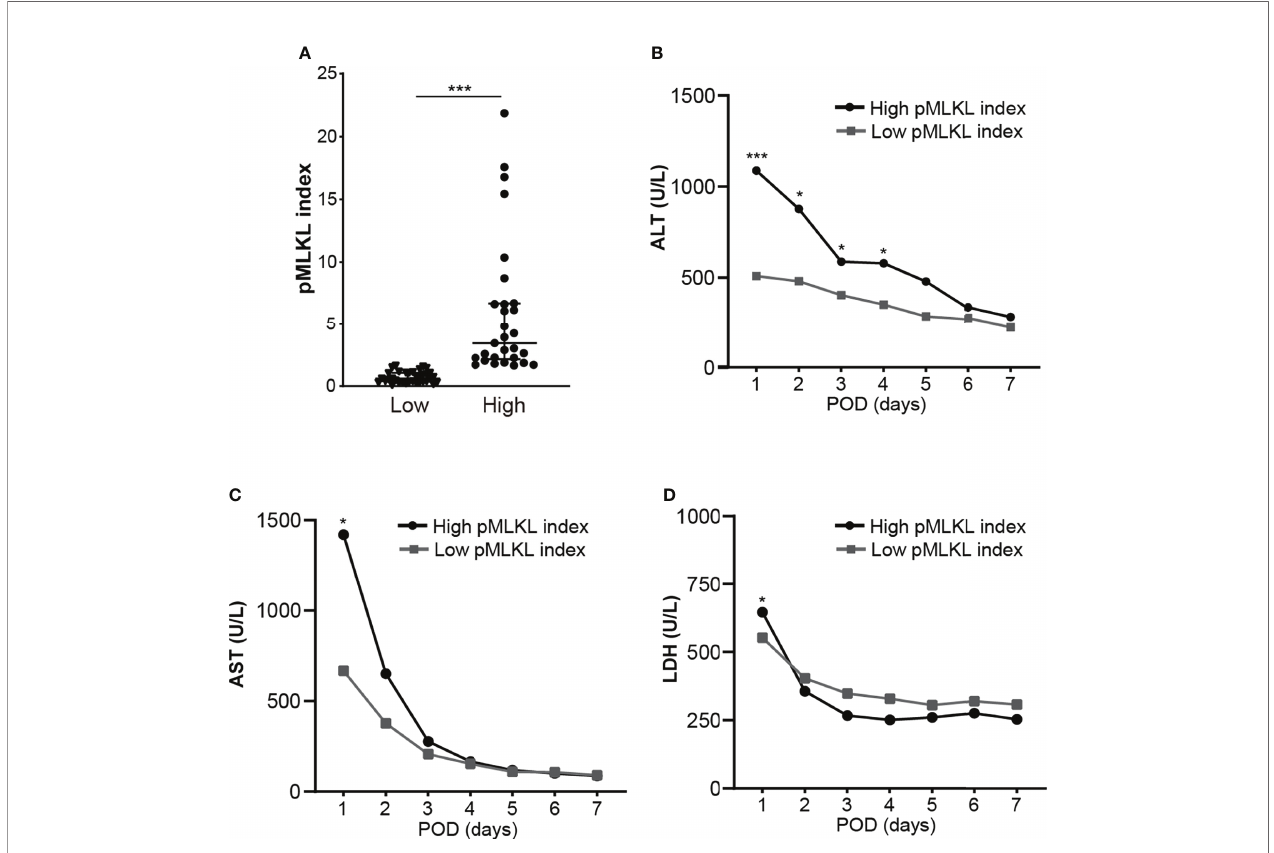
FIGURE 3 | The histological score of pMLKL correlates with early liver injury after reperfusion. (A) The dichotomy of graft pMLKL index is grouped as low and high. Recipients were classi fi ed into low ( ≤ 1.64) versus high (>1.64) pMLKL index. (B, C, D) Levels of serum ALT, AST, and LDH at POD1-7 were compared (median, two-way ANOVA test followed by Sidak ’ s multiple comparisons test). The high pMLKL index group had signi fi cantly higher serum ALT/AST/LDH levels on POD1. Data are presented as the median and interquartile range (IQR). *p < 0.05; ***p < 0.001.